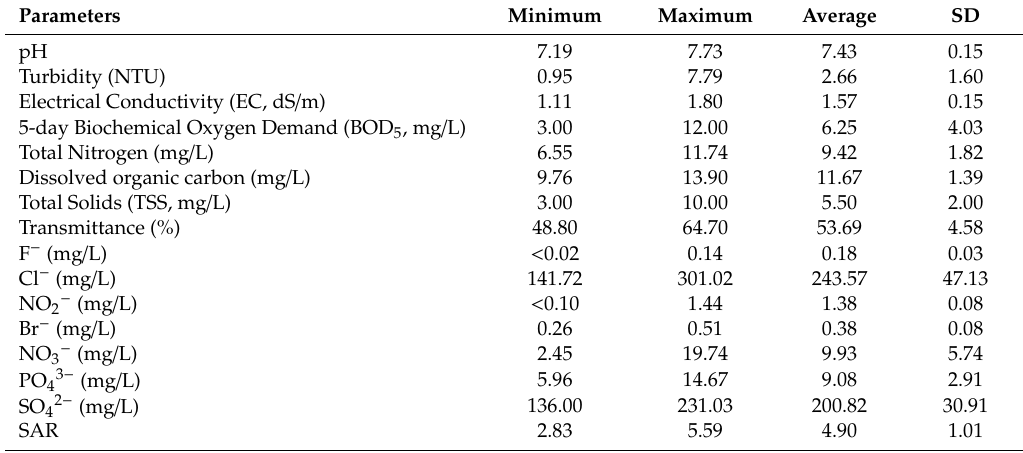
Table 3. Characteristics of secondary wastewater treatment plant effluents ( n = 20).